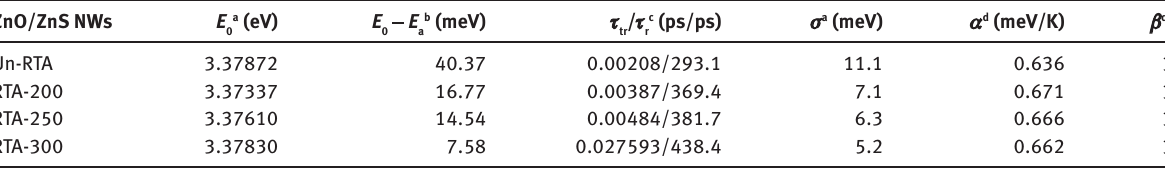
Table 1: The fitting parameters obtained from LSE luminescence model for the four samples. ZnO/ZnS